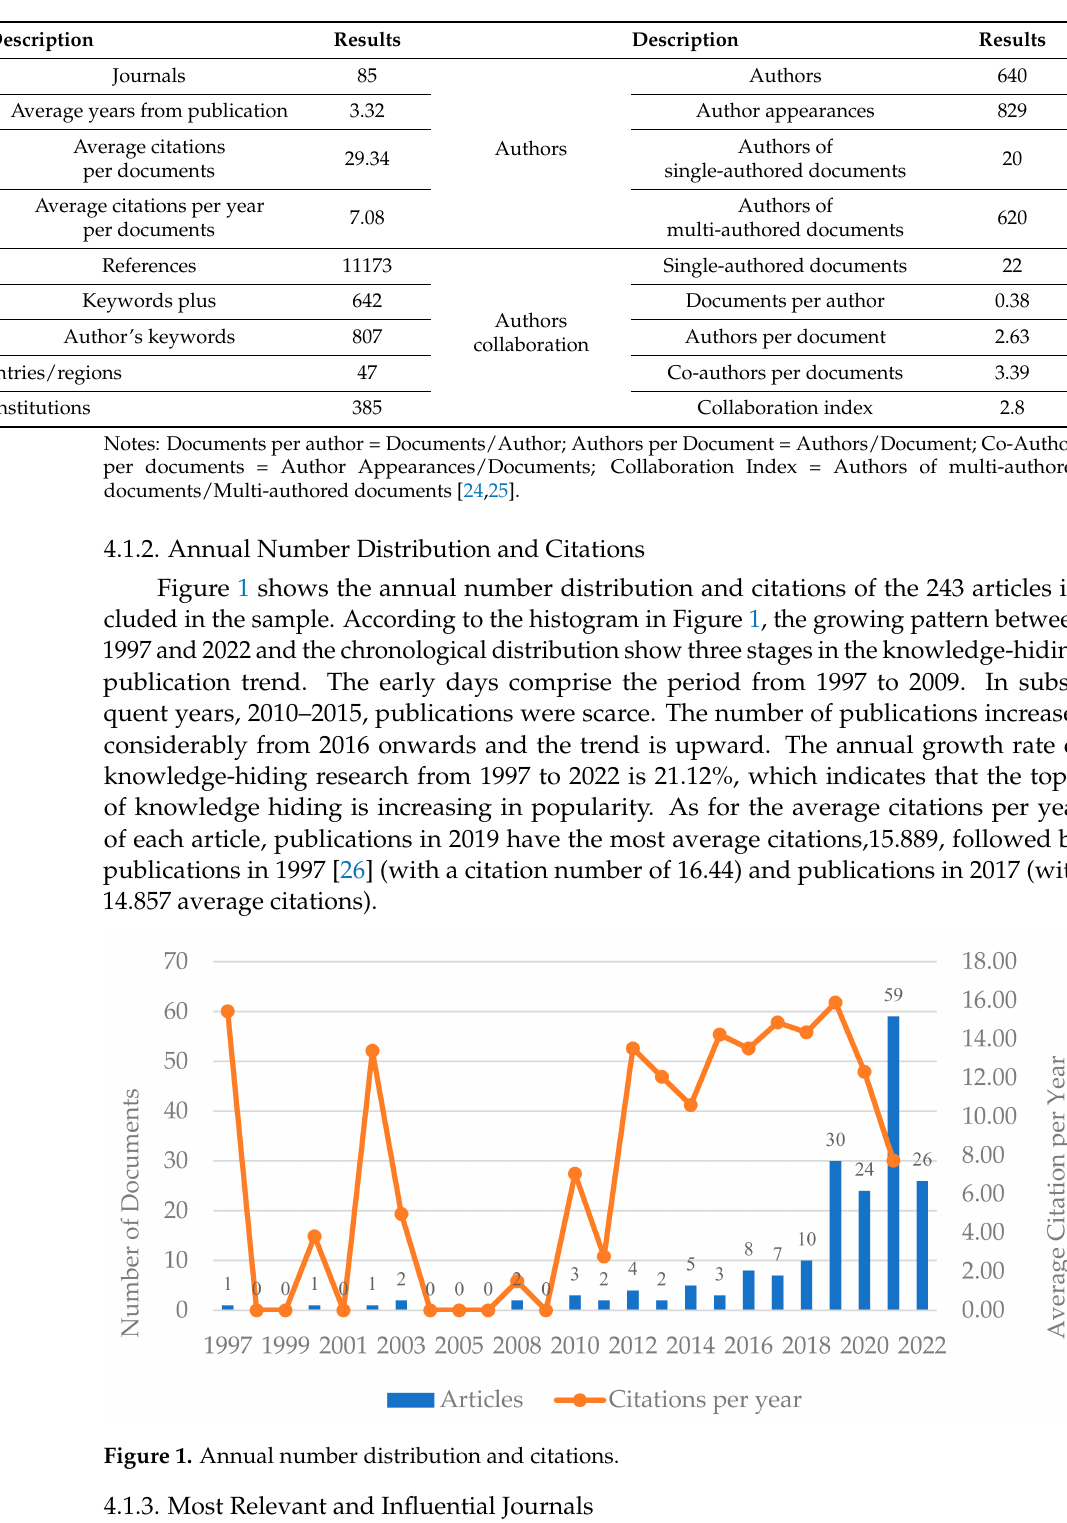
Table 1. Summary of general results.